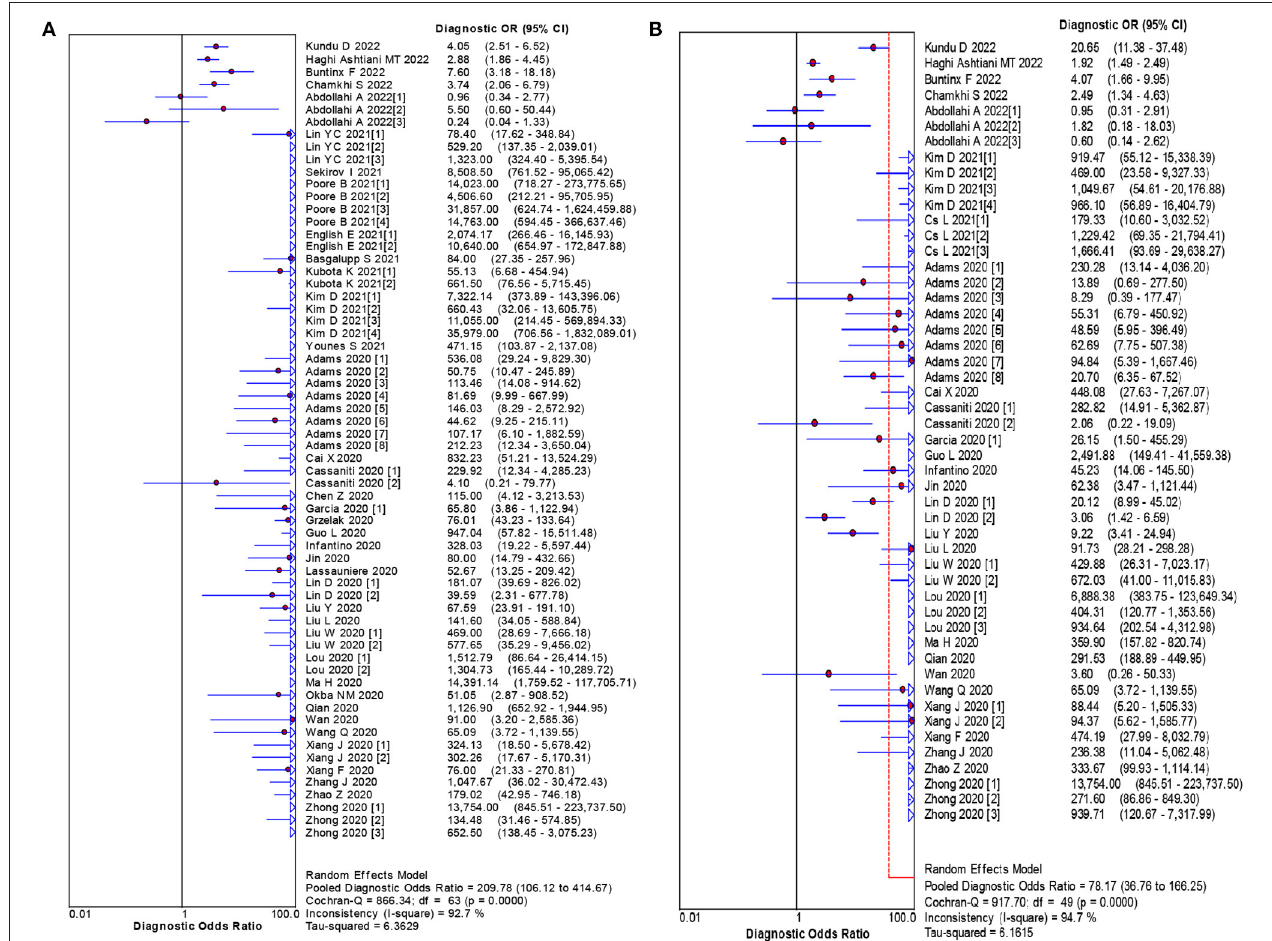
FIGURE 4 | Forest plot of the pooled dOR of IgG (A) and IgM (B) for predicting COVID-19 diagnosis.